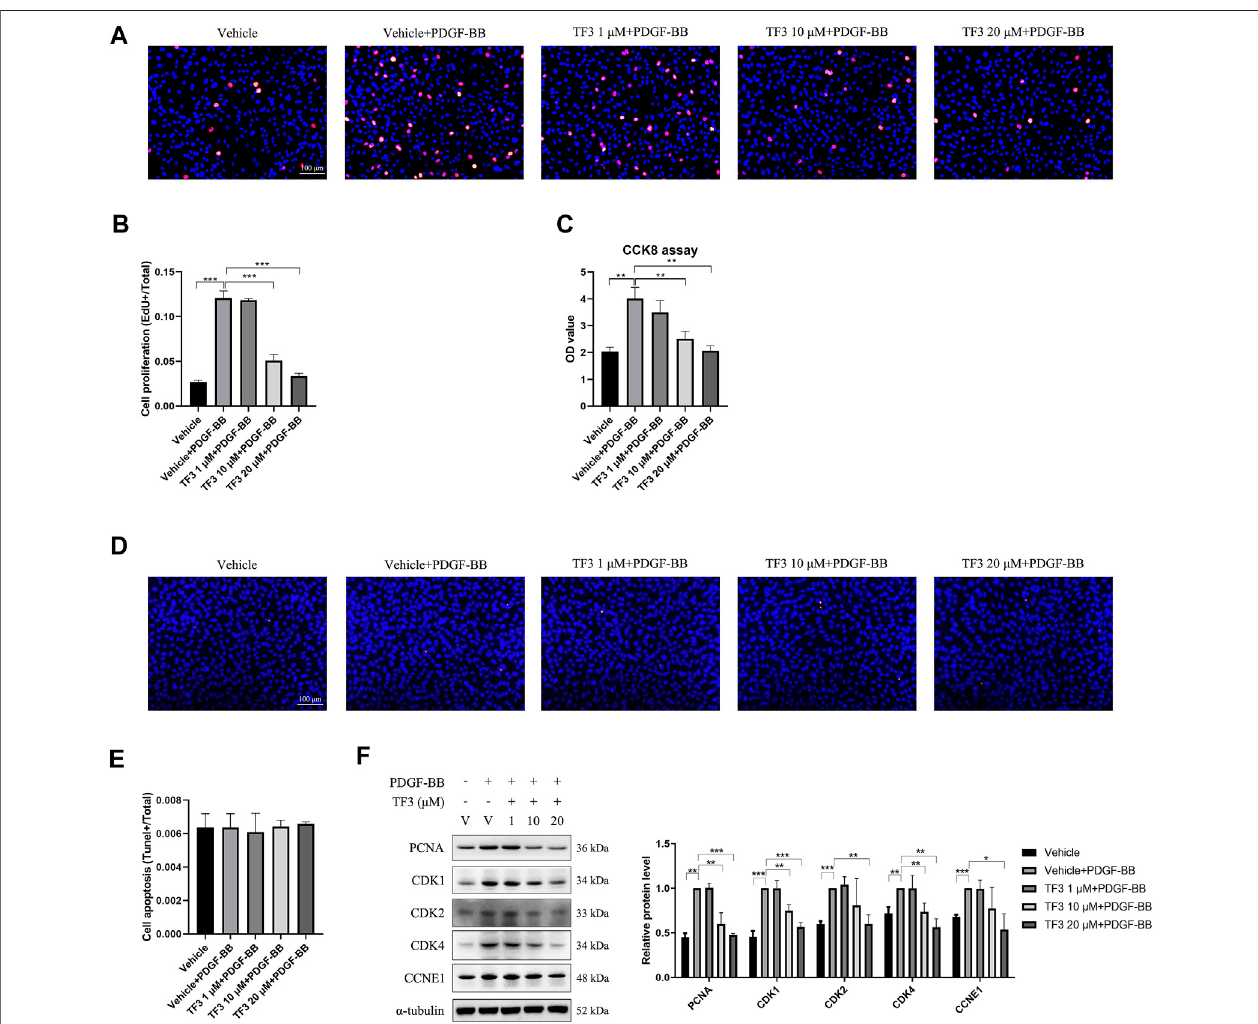
FIGURE 4 | Effects of thea fl avin-3,3 ′ -digallate (TF3) on PDGF-BB – induced proliferation in rat aortic smooth cells (RASMCs). Serum-starved RASMCs were pretreated with 1-, 10-, or 20- μ M TF3 for 1 h and then stimulated with 20 ng/ml PDGF-BB for 48 h. (A) An EdU assay was performed to evaluate the proliferation of RASMCs. (B) StatisticaldataoftheEdUassayareshown. (C) Theeffect ofTF3 onPDGF-BB – inducedproliferation ofRASMCswasalso measured usingCCK-8assay. (D) The effect of TF3 on PDGF-BB – induced apoptosis of RASMCs was measured using terminal deoxynucleotidyl transferase dUTP nick-end labeling (TUNEL) assay. (E) Statistical data from the TUNEL assay are shown. (F) The levels of the cell proliferation-associated proteins PCNA, CDK1, CDK2, CDK4, and CCNE1 were detected by western blotting. The western blot data are shown. Each experiment was performed in triplicate. Scale bar, 100 μ m, * p < 0.05, ** p < 0.01, *** p < 0.001.